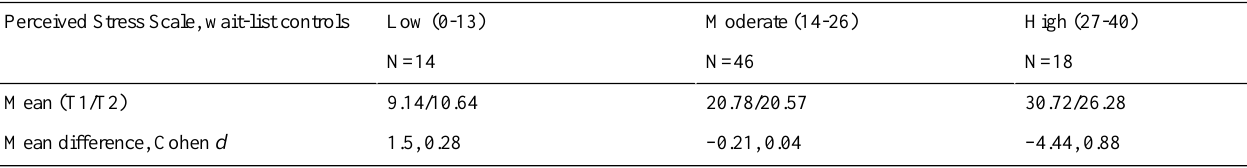
Table 14. Analysis of Perceived Stress Scale categories: